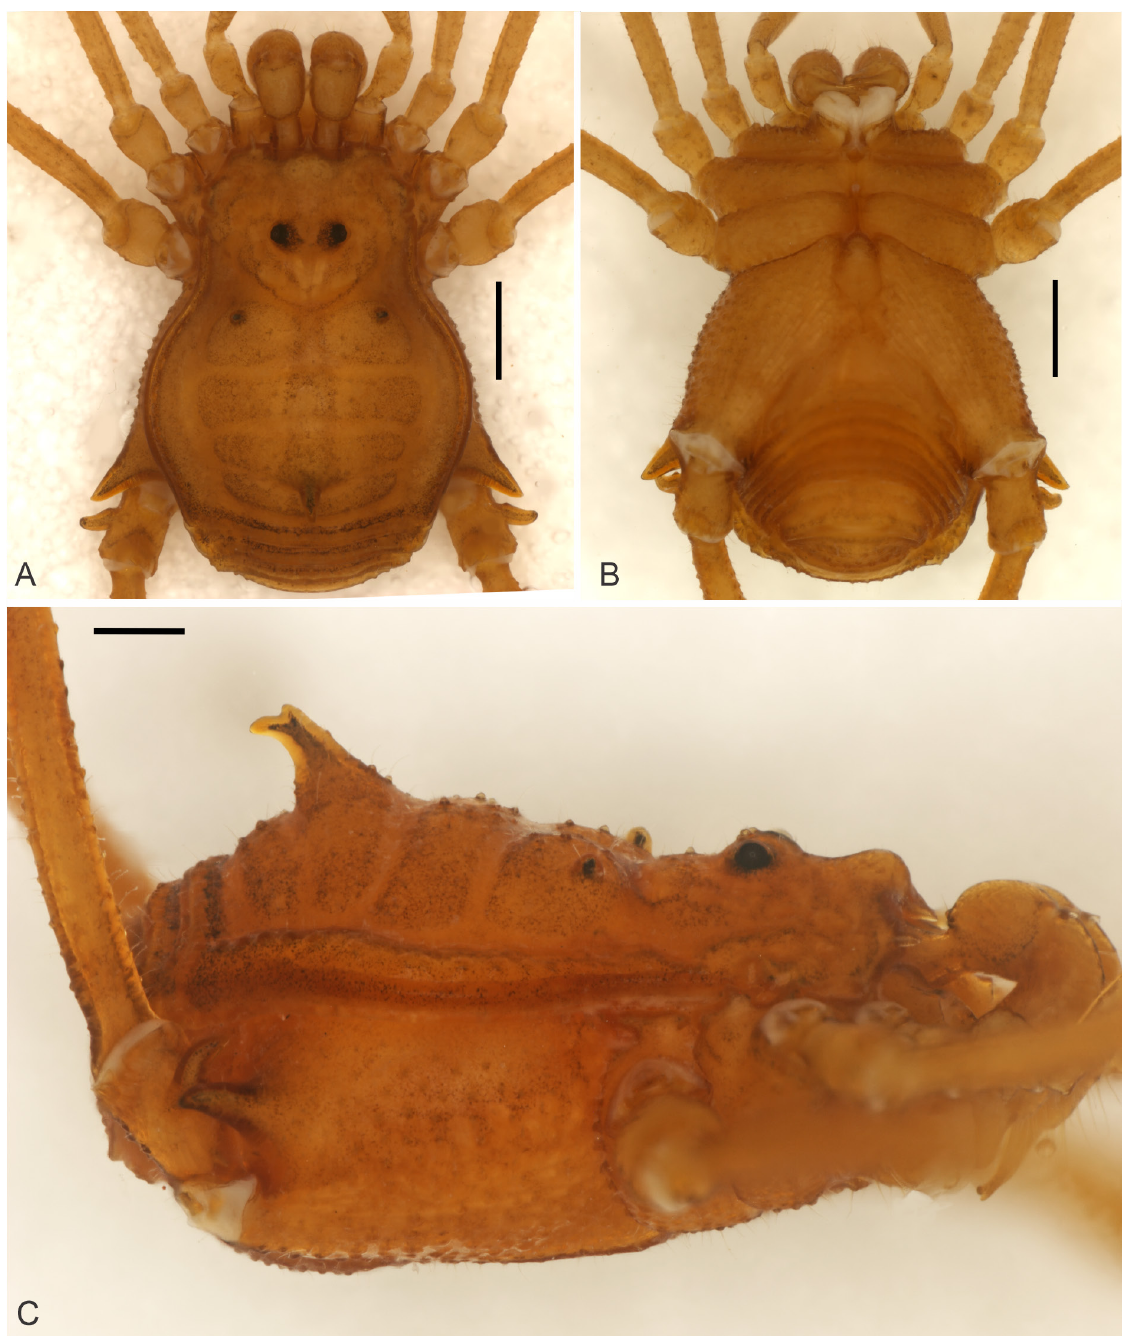
Fig. 1. Eusarcus capixaba sp. nov., ♂, holotype (ISLA 12966), habitus. A . Dorsal view. B . Ventral view. C . Right lateral view. Scale bars: A–B = 1 mm; C = 0.5